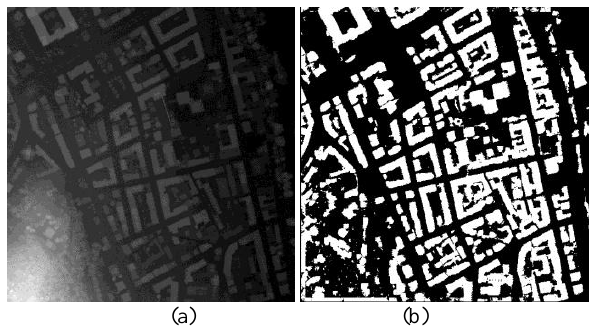
Figure 12. Regularizad DSM (a) and building regions (b).